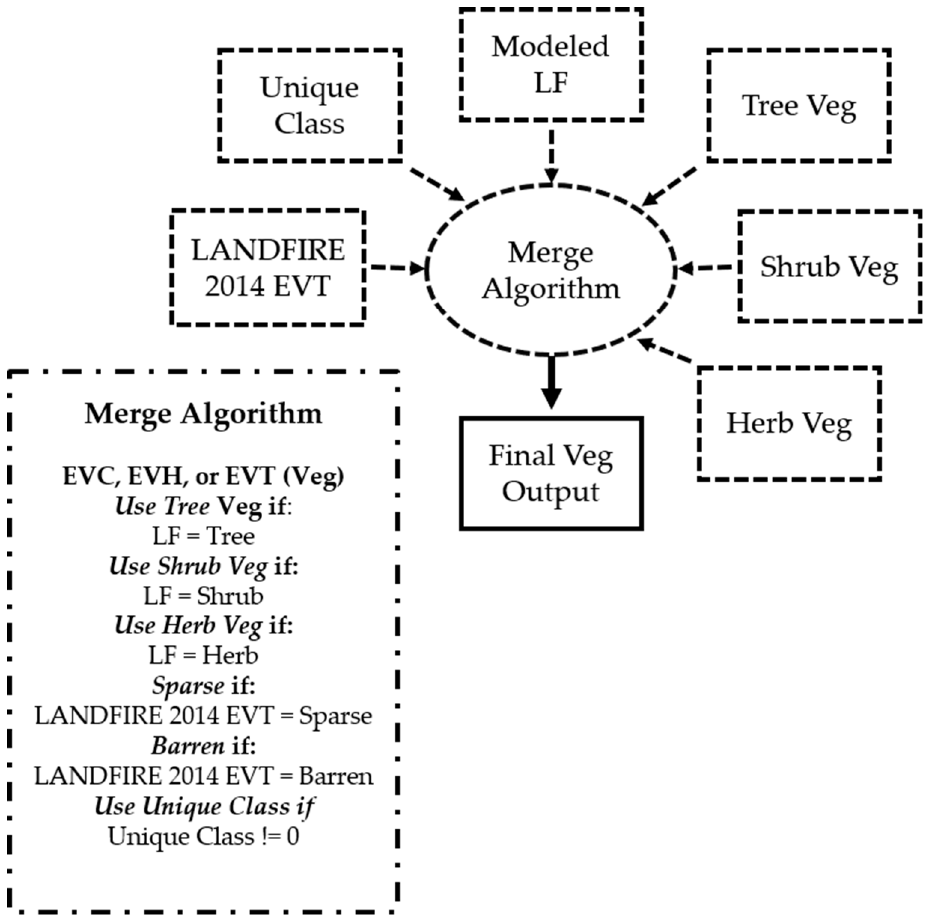
Figure 7. Flowchart and algorithm logic for the creation of LANDFIRE Remap prototype vegetation (Veg) products including Existing Vegetation Cover (EVC), Height (EVH), and Type (EVT) using the modeled lifeform (LF), Veg tree, Veg shrub, Veg herb, LANDFIRE 2014 EVT barren and sparse classes, and additional unique input classes not equal to zero (Unique Class != 0) from water, urban, agriculture, and mines input layers.